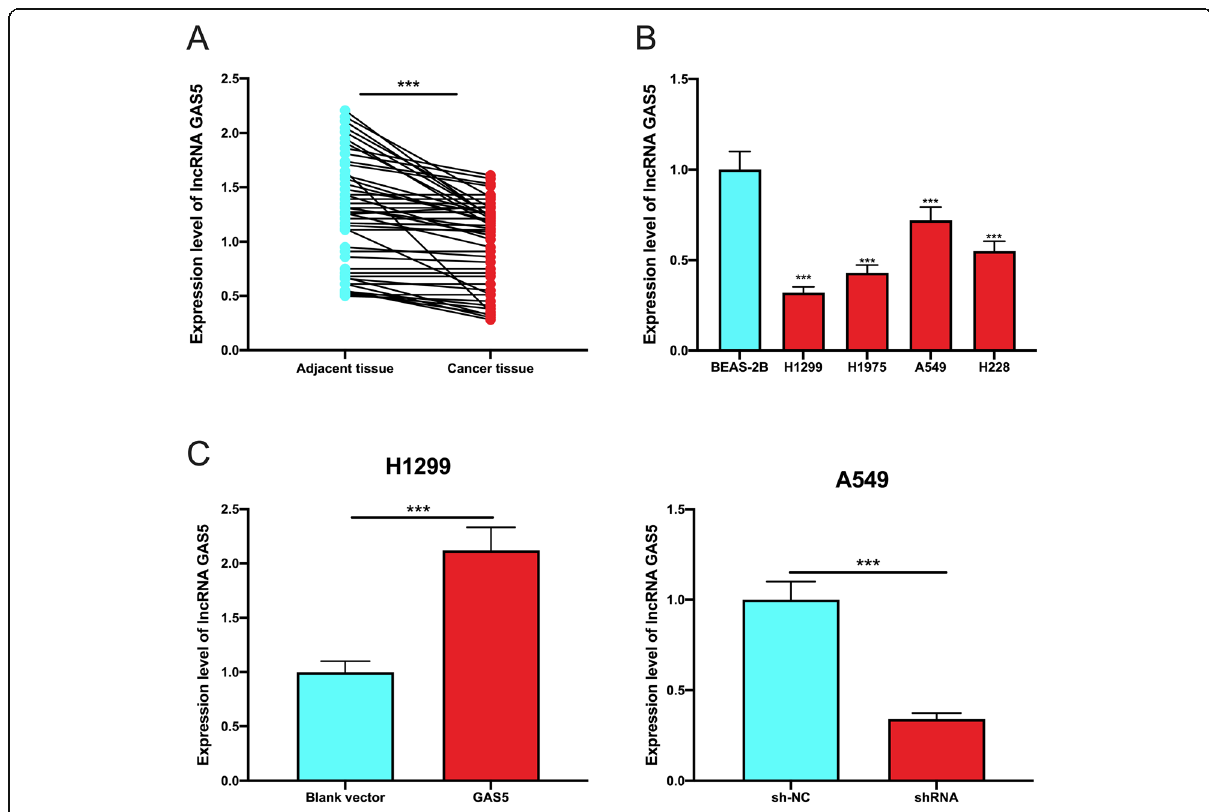
Fig. 1 GAS5 expression in NSCLC. a GAS5 expression in NSCLC tissues and paracancerous tissues was detected using qPCR. b qPCR was utilized to detect GAS5 expression in normal lung epithelial cells and in each NSCLC cell line. c The transfection efficiency of GAS5 overexpression plasmid and shRNA was determined using PCR. *** represents P <